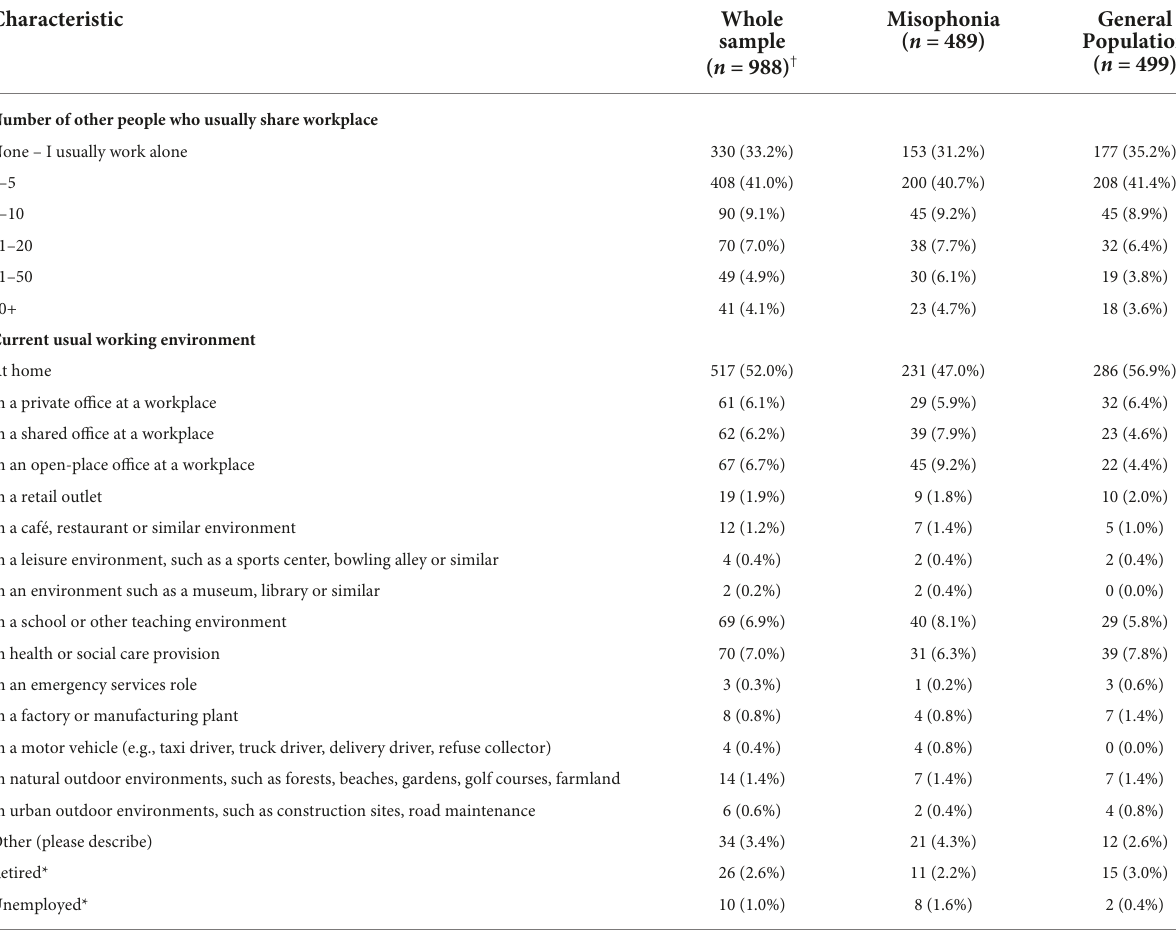
TABLE 4 Participants’ workplace